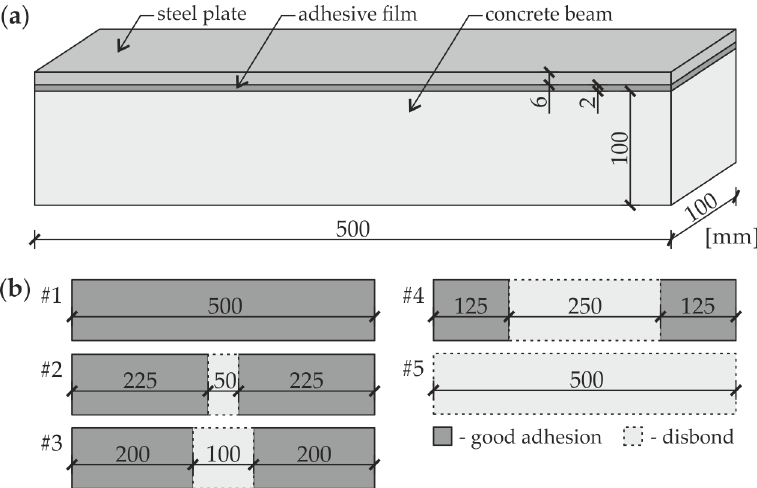
Figure 1. Analyzed specimens: ( a ) geometry of beams and ( b ) variants of defects.